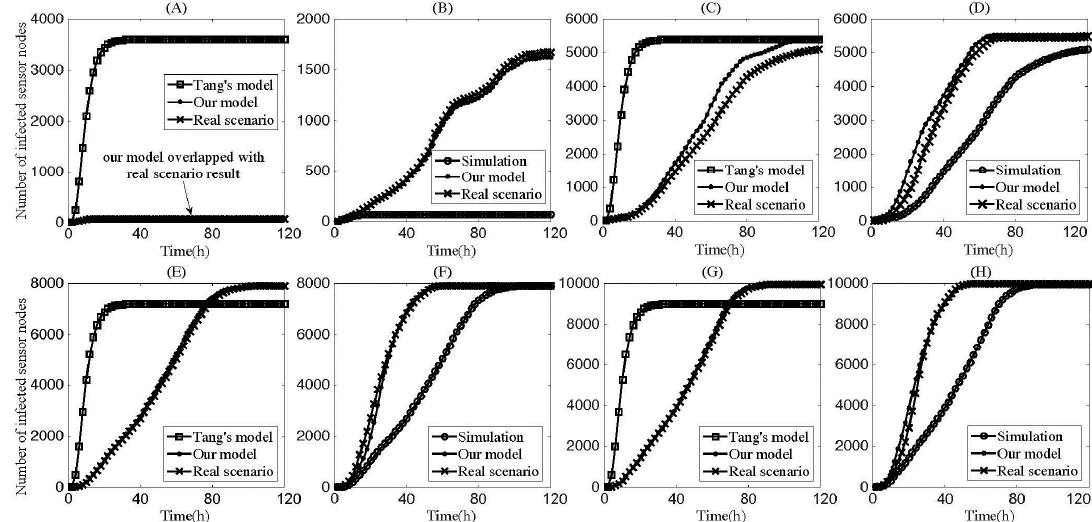
Figure 6. Number of infected nodes vs. propagation time when no defense strategies are implemented. The network sizes of ( A , B ) are 4000; of ( C , D ) are 6000; of ( E , F ) are 8000; and of ( G , H ) are 10000. Additionally, ( A , C , E , G ) are circumstances with only static sensor worm while ( B , D , F , G ) are circumstances with the mobile sensor worm.